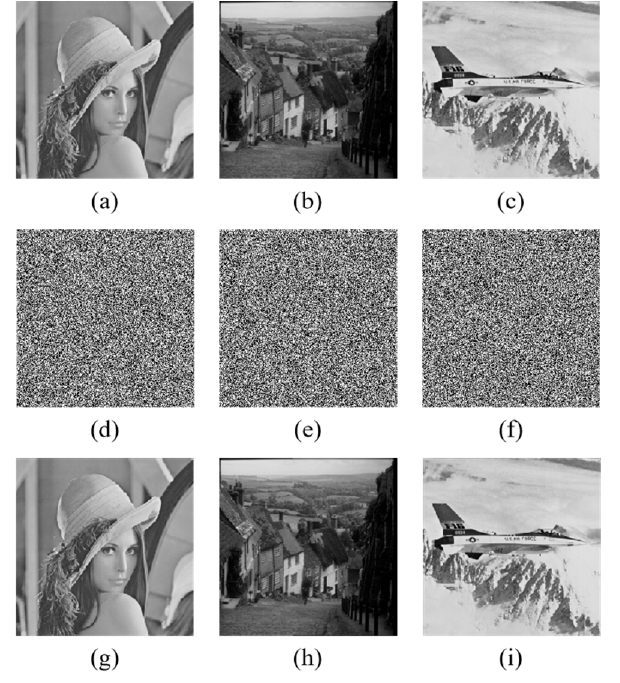
Figure 16. Encryption and decryption of color images. ( a – c ) are all kinds of images of 256 × 256, ( d – f ) are corresponding encrypted images, ( g – i ) are corresponding decrypted images. Figure 17 is the histogram of the original image and the encrypted image in Figure 16.